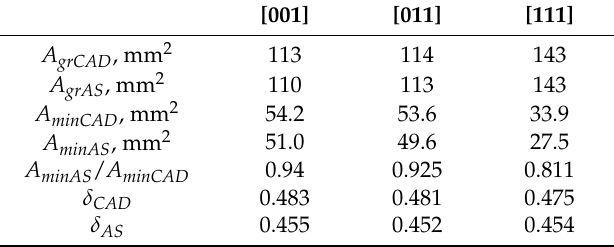
Table 1. Gross and net cross sections and densities for the CAD models and the actual specimens. [001] [011]